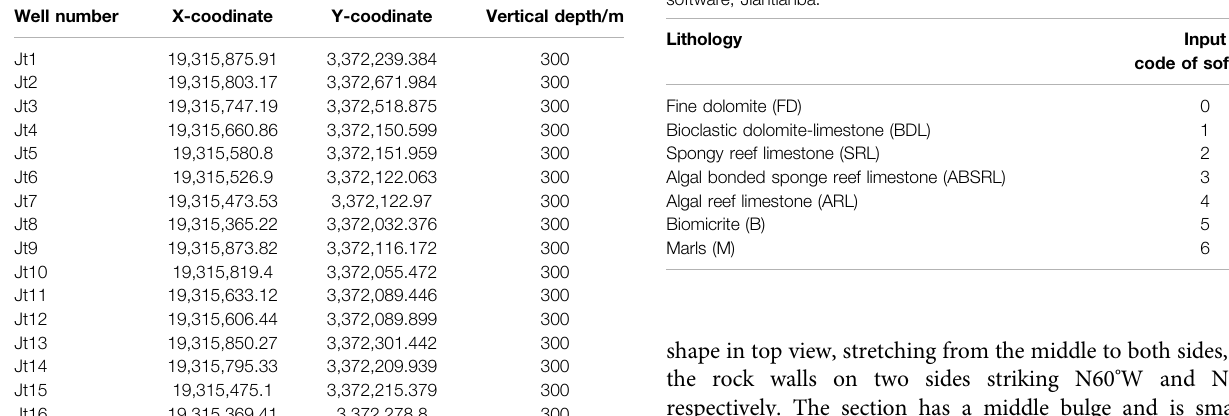
TABLE 2 | Coordinate data information of virtual wells of outcrop,